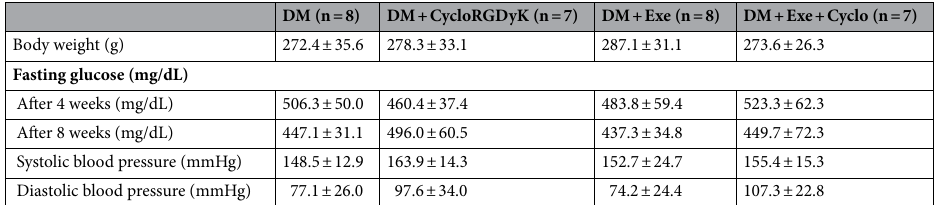
Table 2. Physical and metabolic parameters of experimental groups following eight weeks of aerobic exercise training and treatment with CycloRGDyK. Results are means ± SE. CT, nondiabetic; DM, sedentary diabetic; DM + Exe, exercised diabetic.